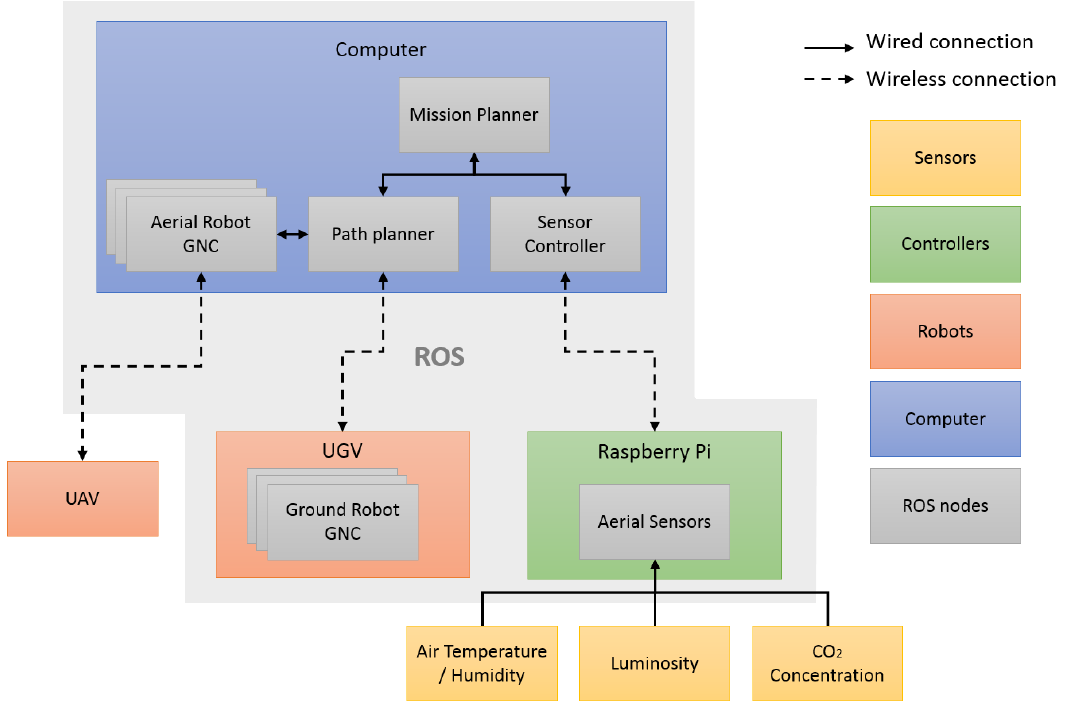
Figure 4. ROS architecture with robots, sensors, controllers and the central computer.